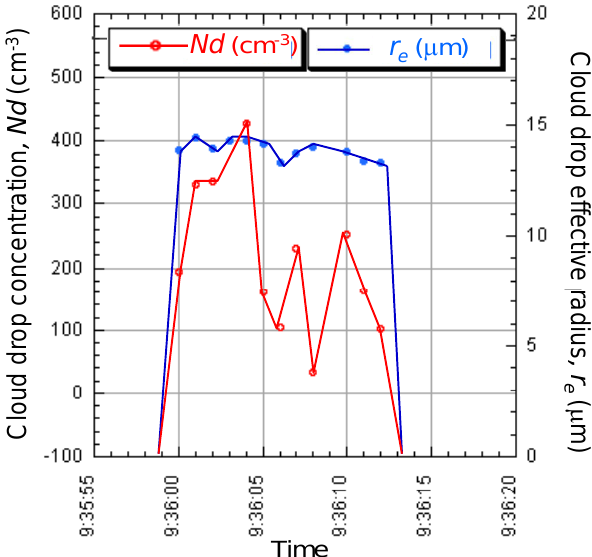
Fig. 5. The cloud droplet effective radius, r e , versus the droplet mean volume radius, r v , for 1Hz averaged droplet size distributions measured for various locations, cloud types and by different cloud droplet probes. Note the universally highly repeatable and tight r e – r v relationship (from Freud and Rosenfeld,